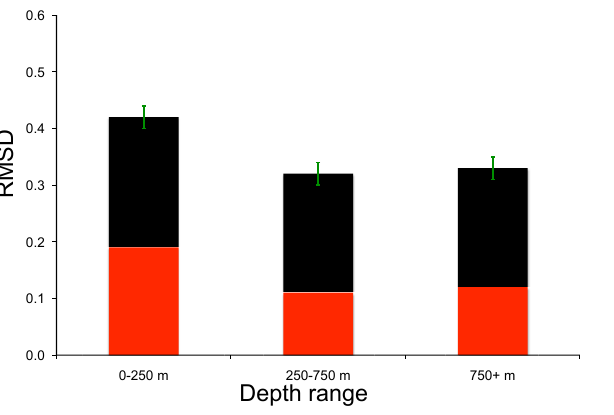
Fig. 9. Average RMSD for all 21 models at each depth range. Green error bars are 2 × standard error. Red bars represent the maximum reduction in RMSD when the uncertainty in both the input variables and in situ NPP measurements are considered.